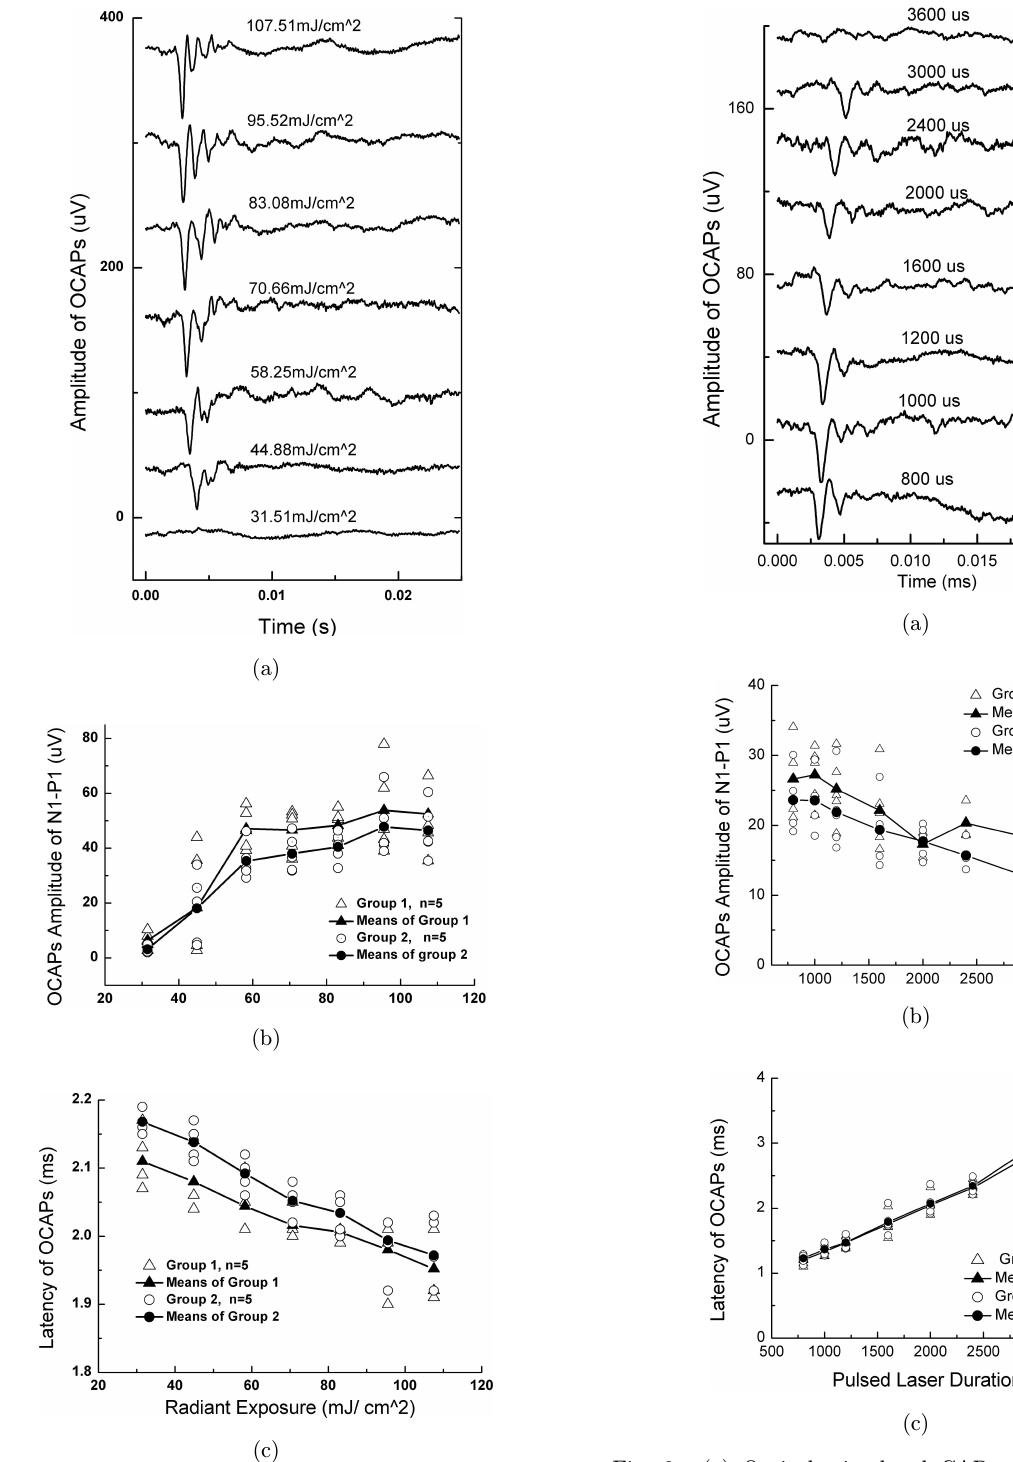
Fig. 6. (a) Optical stimulated CAPs obtained at constant radiant exposure (44.88 mJ/cm 2 ) with di®erent pulse durations, from the bottom to the top: 800, 1000, 1200, 1600, 2000, 2400, 3000 and 3600 (cid:1) s. (b, c) The amplitudes of N 1 – P 1 and latency of N 1 for all animals in two groups are plotted as hollow triangles and hollow circles, respectively. Solid triangles and circles stand for their respective means.